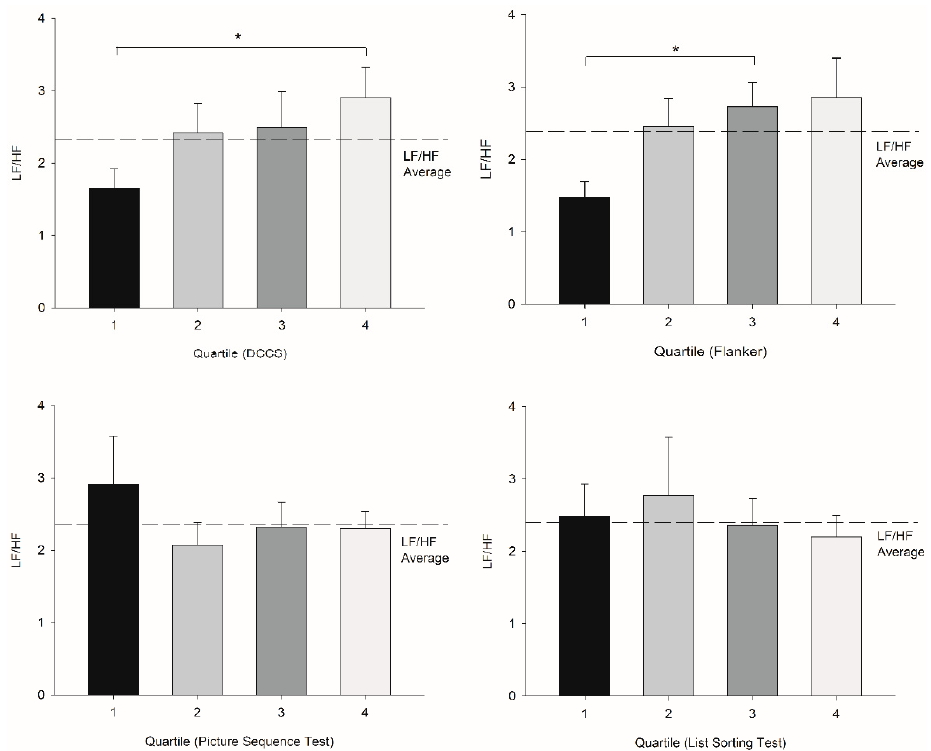
Figure 3. Upper left: Quartile comparisons (determinants: DCCS) in terms of LF/HF (error bar: SE) demonstrate that there was a significant difference between quartile 1 and quartile 4. (U = 55, and * p = 0.007) Upper right: Quartile comparisons (determinants: Flanker) in terms of LF/HF demonstrate that there was a significant difference between quartile 1 and 3 (U = 35, and * p = 0.004 for quartile 1 and quartile 3) Lower left: Quartile comparisons (determinants: Picture Sequence) in terms of LF/HF did not demonstrate any significant differences. Lower right: Quartile comparisons (determinants: List Sorting) in terms of LF/HF did not demonstrate any significant differences.